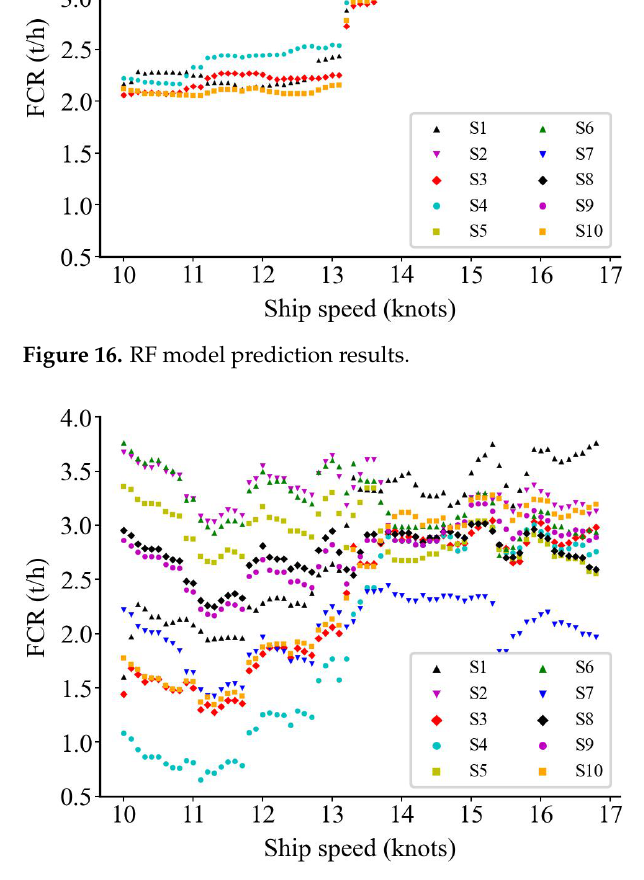
Figure 17. Xgboost model prediction results.